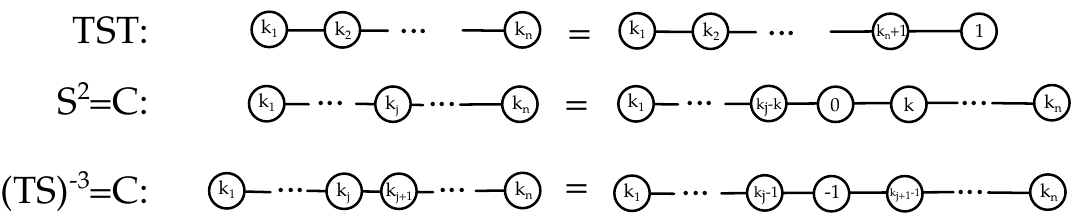
Figure 3 . The relations TST , S 2 and ( TS ) (cid:0) 3 acting on the plumbing data associated to the